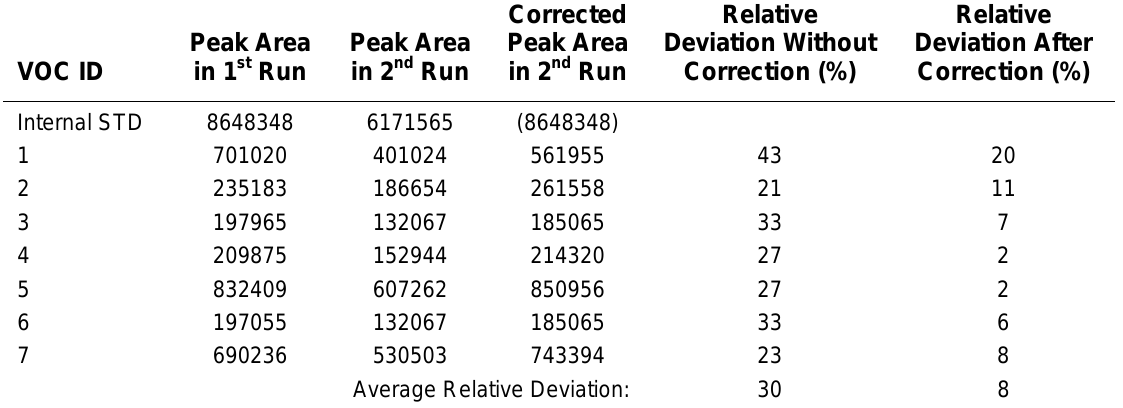
Comparison of Relative Divisions in Duplicate Analysis of Several VOCs With and Without Internal